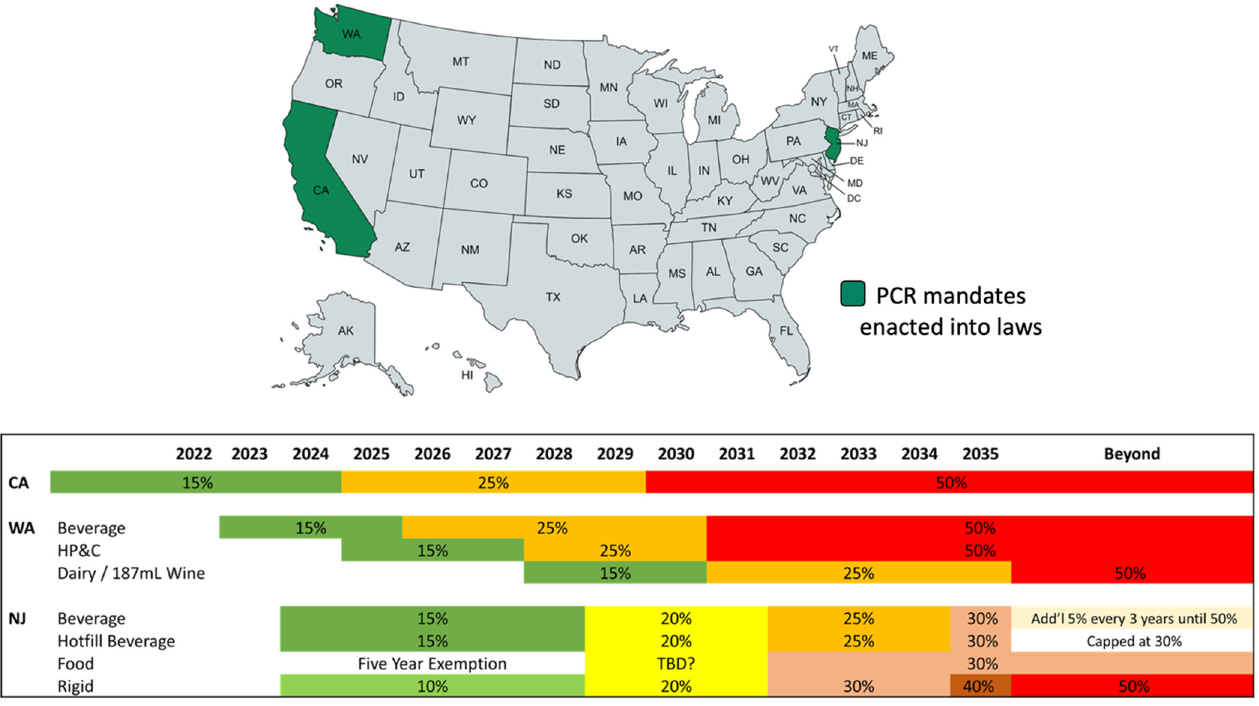
Figure 18. US PCR mandates across different states, California (CA), Washington (WA), and New Jersey (NJ), by May 2022.